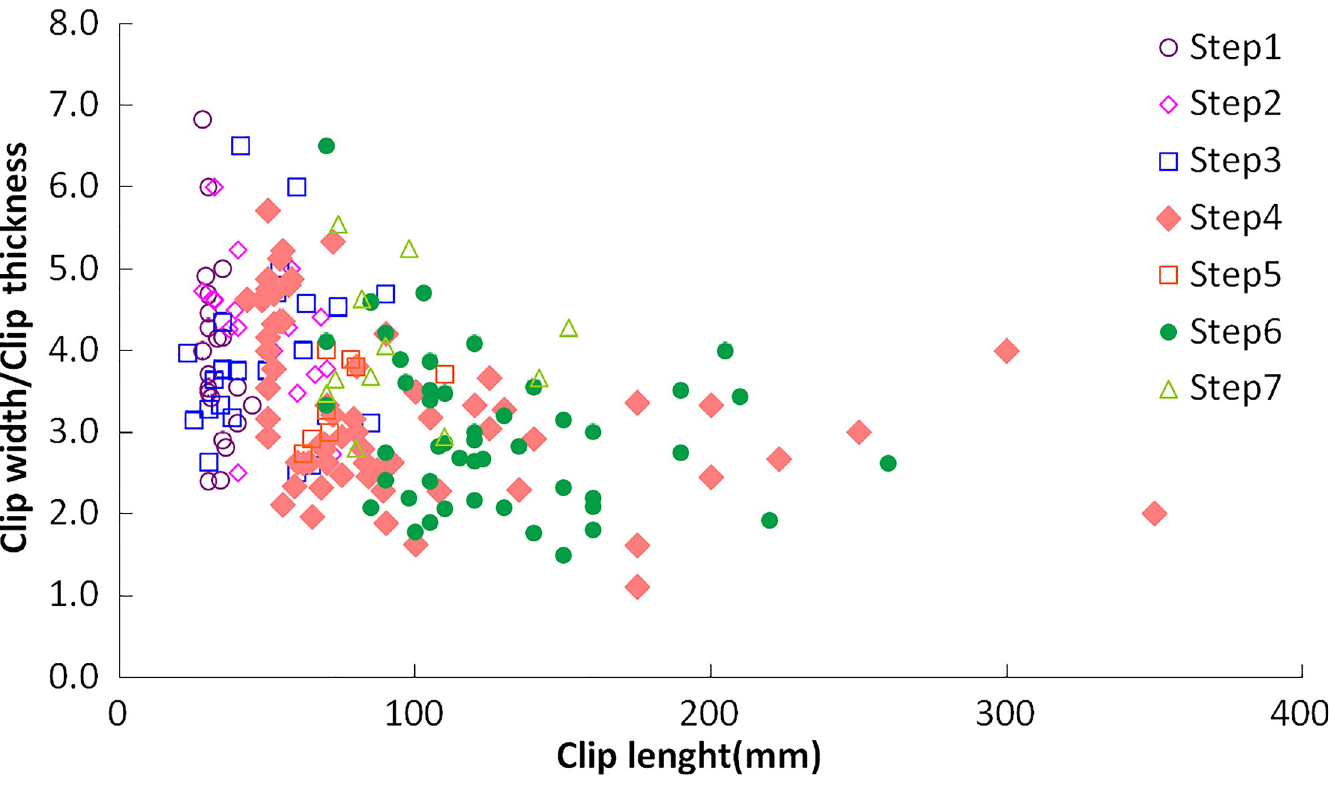
Fig 29. The ratio of chip width to chip thickness.